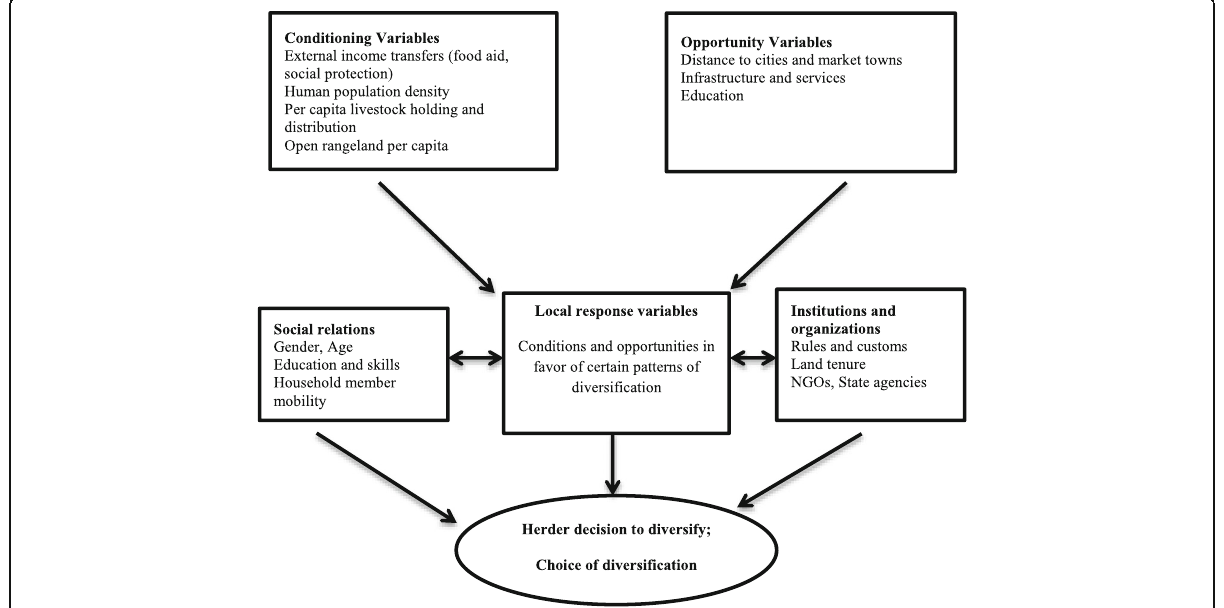
Figure 1 A framework for pastoral livelihood diversification. After Little et al. (2001b, p.